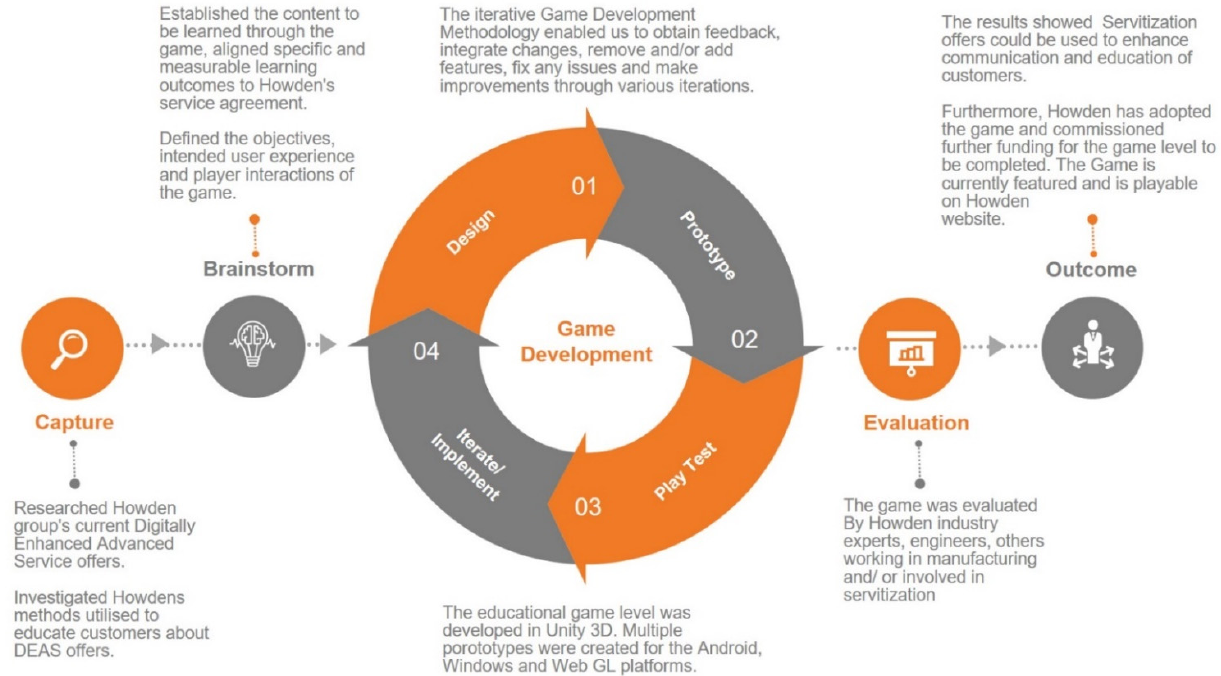
Figure 1. Schematic of the game development process.